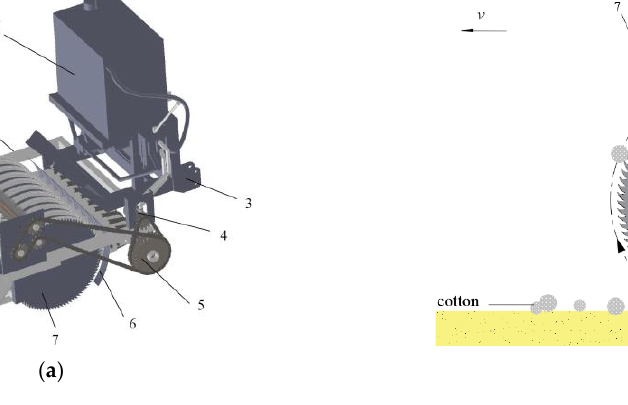
Figure 1. Cotton recovery device: 1. frame; 2. hydraulic device; 3. hangers; 4. hydraulic motor; 5. sprockets; 6. straw shield; 7. sawtooth roll-tie cotton-picking mechanism; 8. cotton collection box; and 9. cotton unloading mechanism. ( a ) Structure diagram of the cotton recovery device. ( b ) Schematic diagram of the principle of the cotton recovery device. Table 1. Main technical parameters of the cotton recovery device.